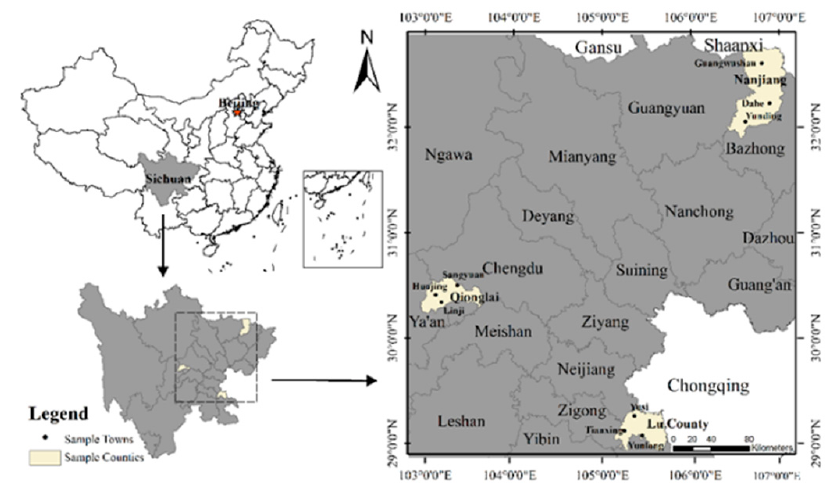
Figure 2. Distribution map of sample villages.